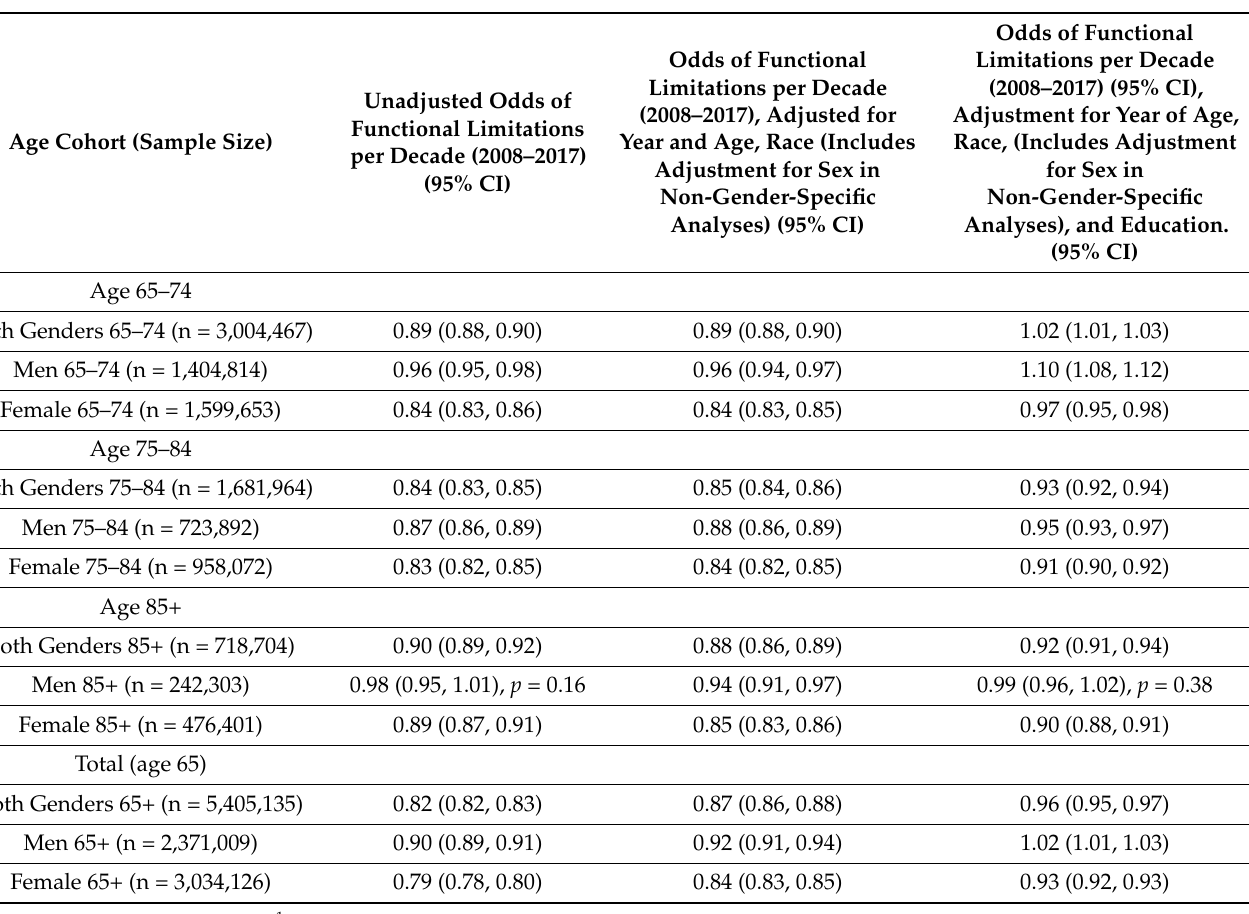
Table 4. Temporal trends in the odds of functional limitations (FLs 1 ) per decade. Odds and 95% confidence intervals ( p < 0.001, unless otherwise indicated). Source: American